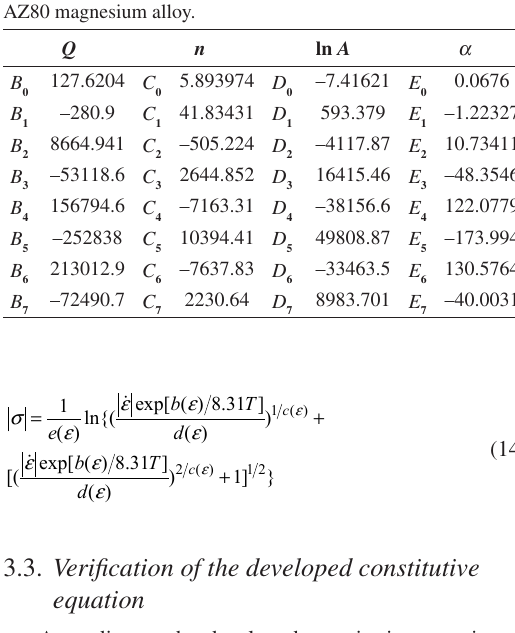
–7.41621 E 0 593.379 E 1